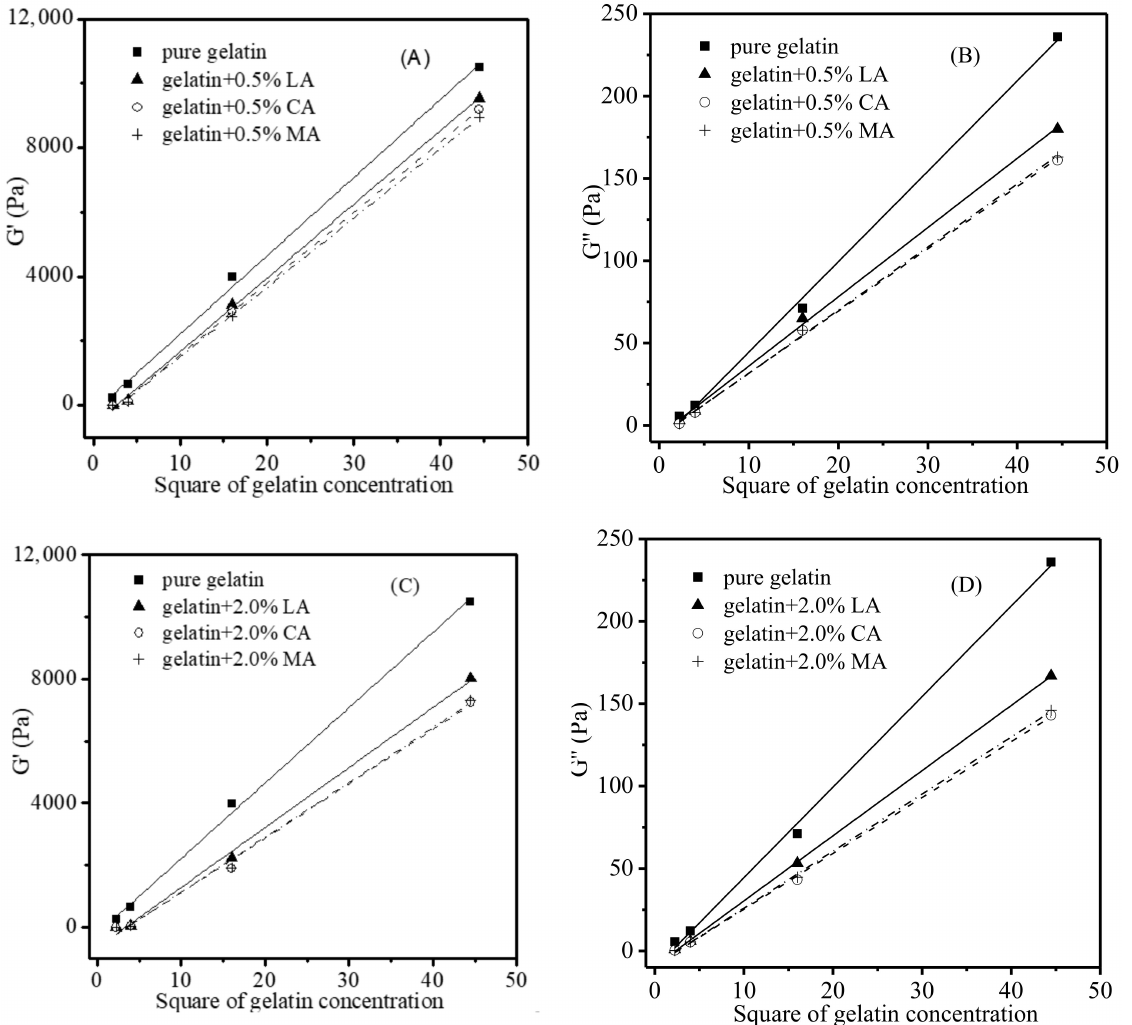
Figure 6. G (cid:48) and G (cid:48)(cid:48) of gelatin gels (2 ◦ C) with different levels of LA, CA and MA versus square of gelatin concentrations. G (cid:48) —0.5% ( A ), G (cid:48) —2.0% ( B ), G (cid:48)(cid:48) —0.5% ( C ), G (cid:48)(cid:48) —2.0% ( D